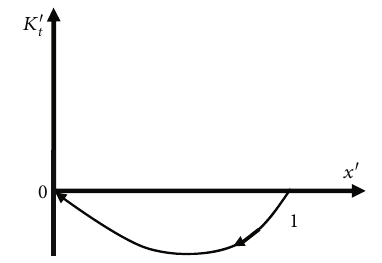
Figure 6: Bank selects the lack of credit strategy.